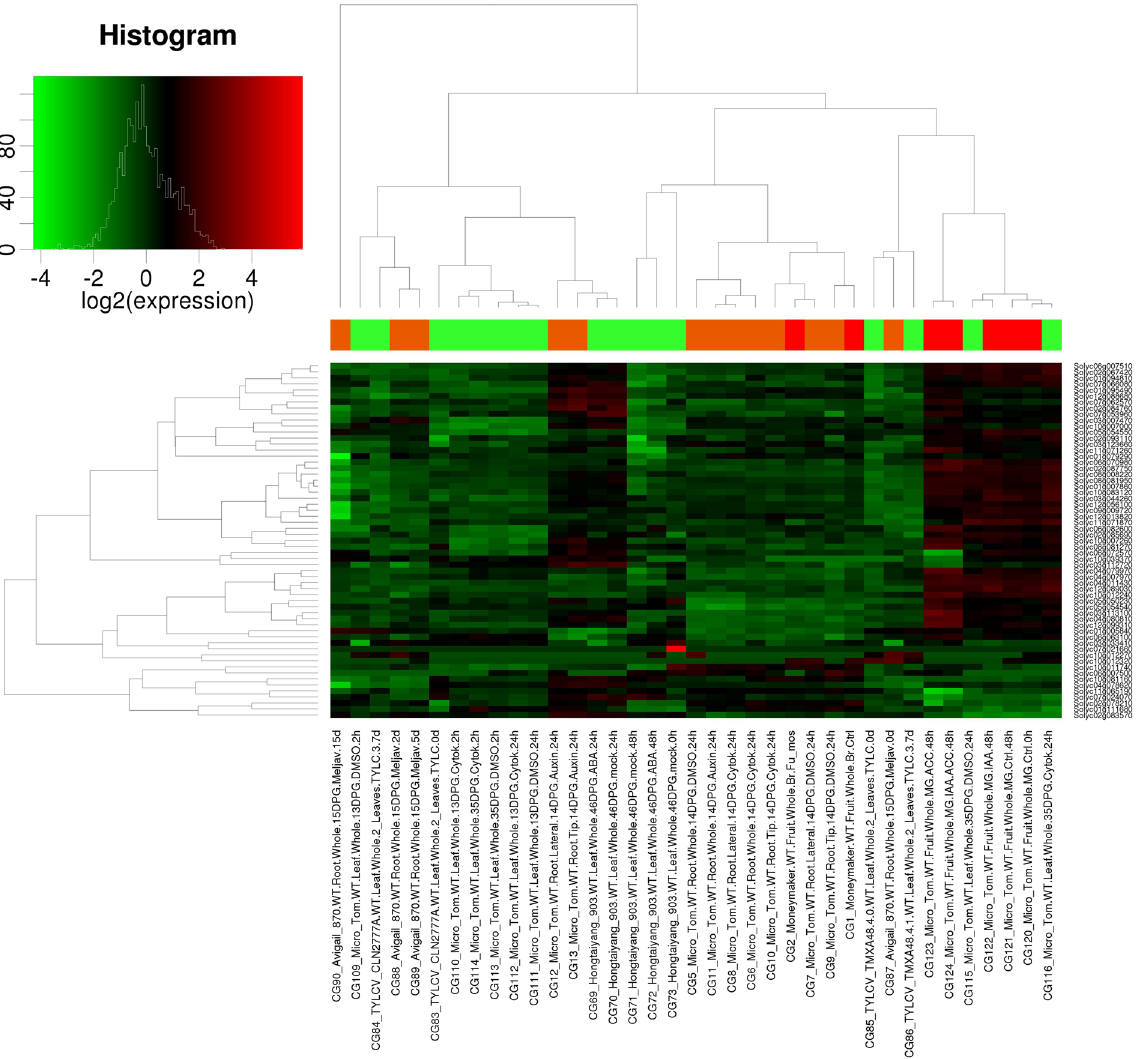
Figure 7. A gene expression profile of 59 tomato E2 enzyme sequences during hormone treatment and pathogen infection in root, leaf and fruit tissues of Micro Tom, Avigail, Hongtaiyamg, Moneymaker cultivars of tomato. The normalized gene expression level is represented by a color scale